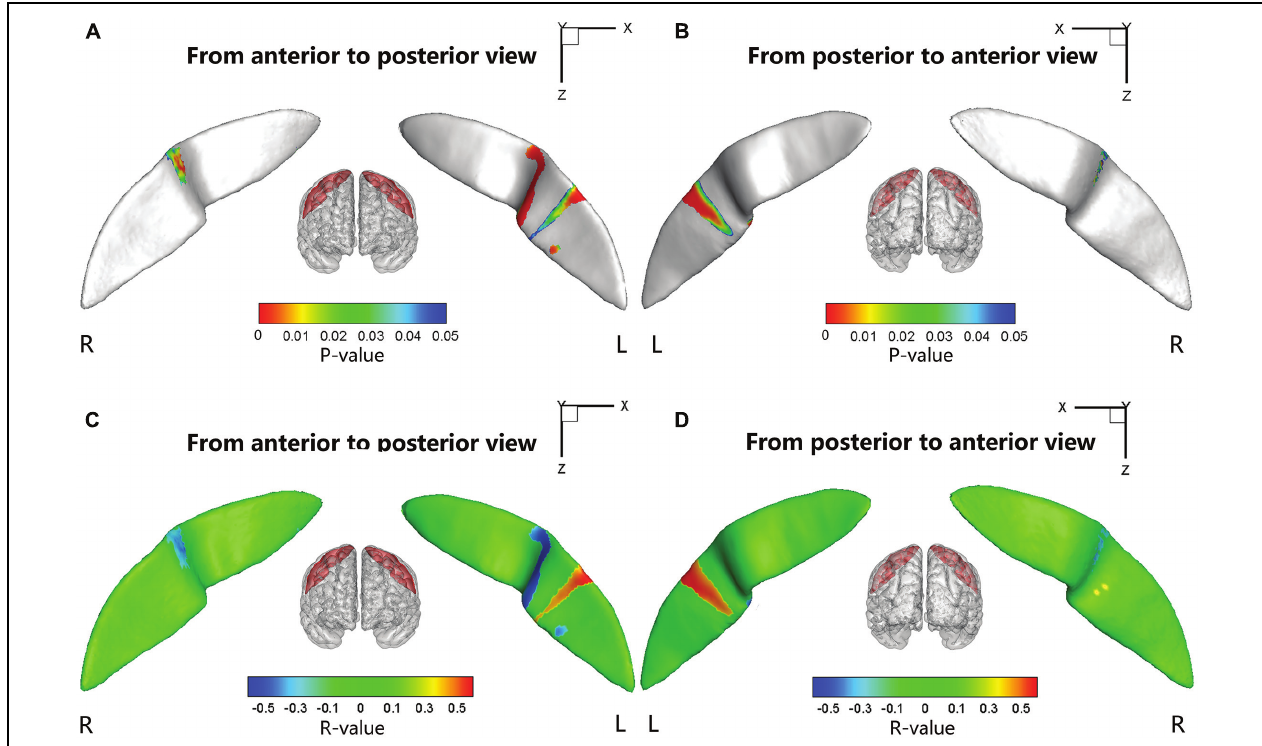
FIGURE 6 | The correlation between the node-based sulcal profiles and the inattention scores using age and gender as the covariates. The focal regions with significant positive correlations ( t < 0, P < 0.05) were mapped onto the average surface of the CS. Notably, we first defined the regions showing significant differences in the sulcal profile